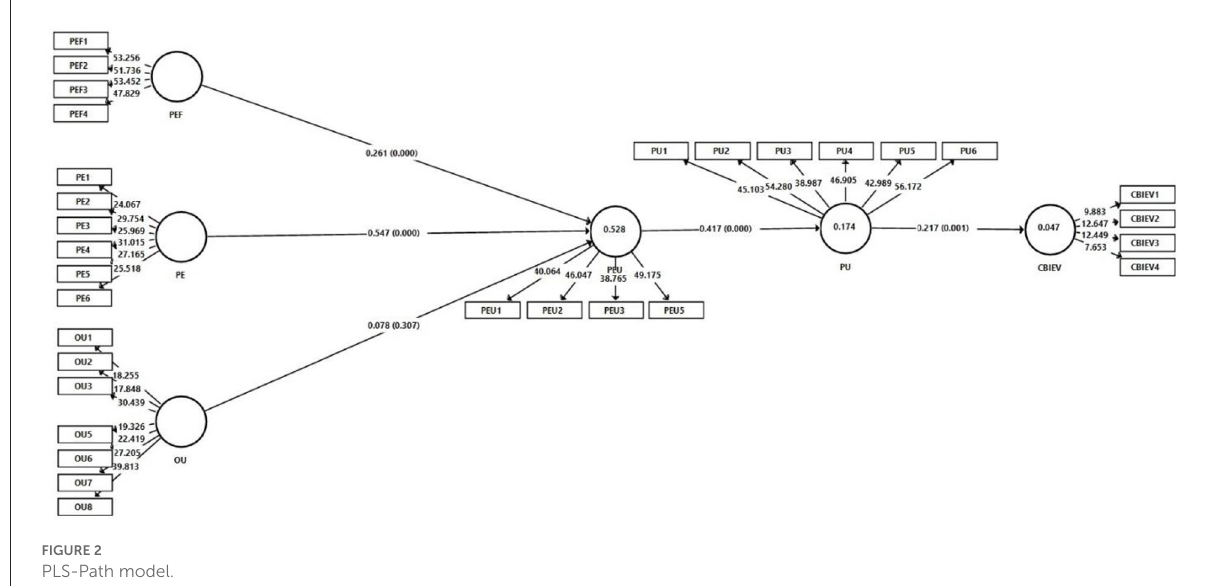
FIGURE2 PLS-Path model.